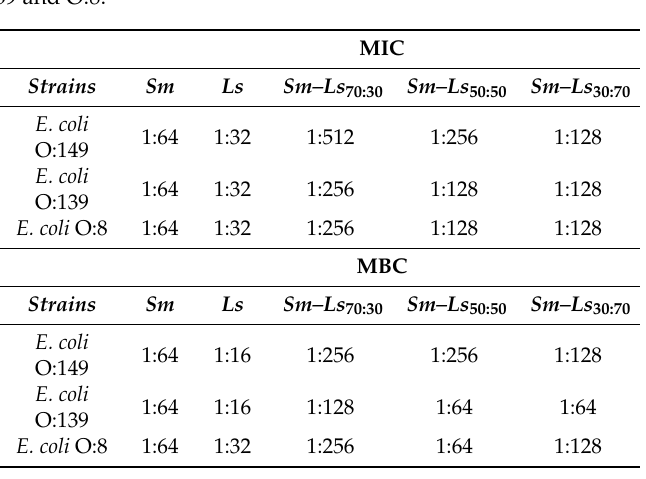
Table 3. Mode of minimum inhibitory concentration (MIC) and minimum bactericidal concentration (MBC) values of winter savory ( Sm ) and manuka ( Ls ) essential oils (EOs) against Escherichia coli wild strains O:149, O:139 and